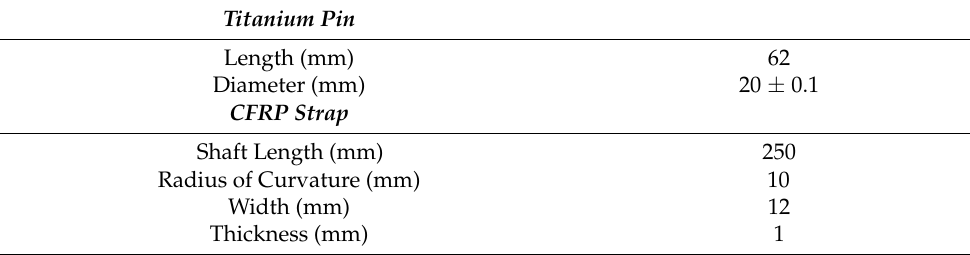
Table 4. Pin and strap